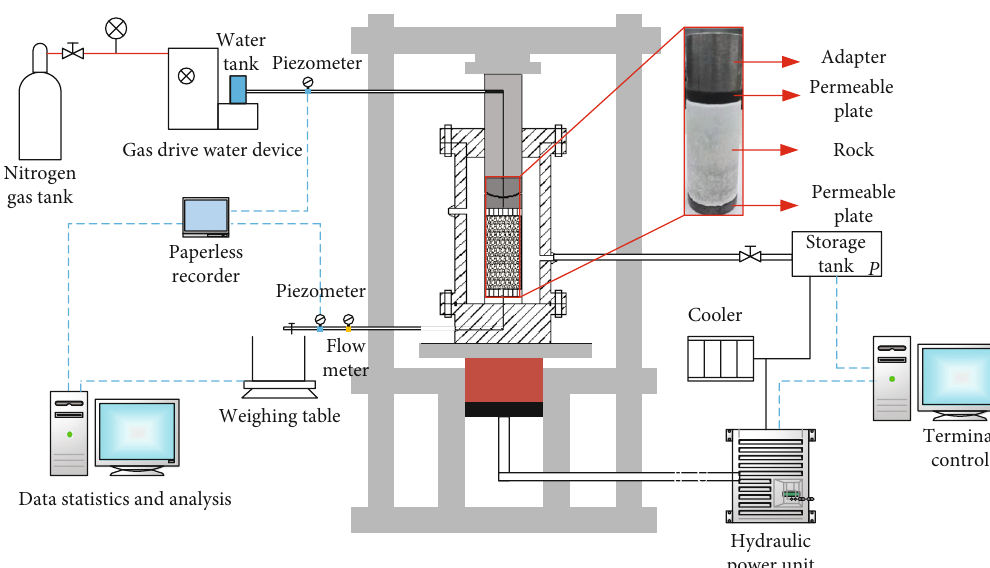
Figure 9: Seepage test system for weakly cemented rock